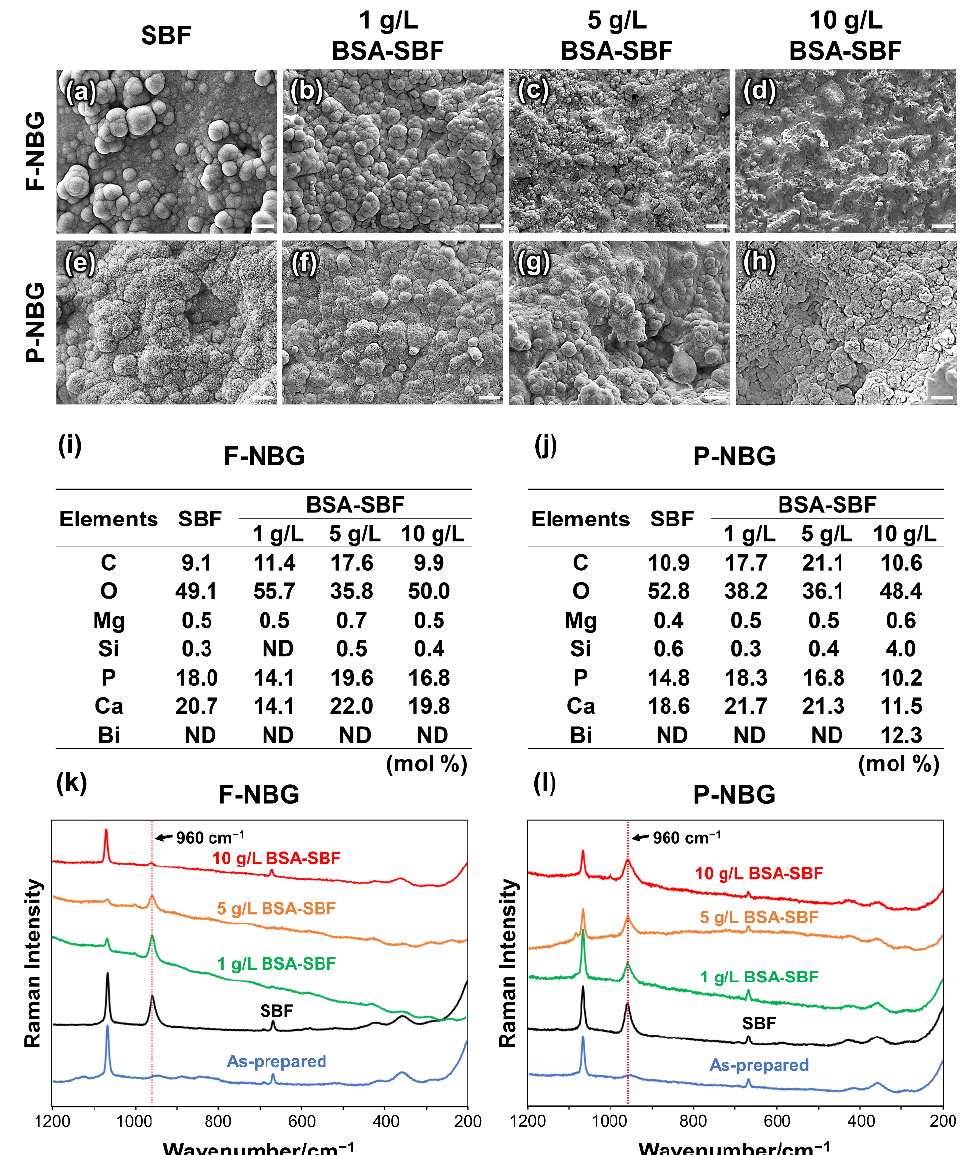
Figure 1. Representative ultrastructure ( a – h ), elemental composition ( i , j ), and Raman spectra ( k , l ) of the surface of flowable and putty-form Nishika Canal Sealer BG Multi (F-NBG and P-NBG) aged in simulated body fluid (SBF) or 1-, 5-, or 10-g/L bovine serum albumin-containing SBF (BSA-SBF). C: carbon; O: oxygen; Mg: magnesium; Si: silicon; P: phosphorus; Ca: calcium; Bi: bismuth. ND: Not detected. Scale = 10 μm.